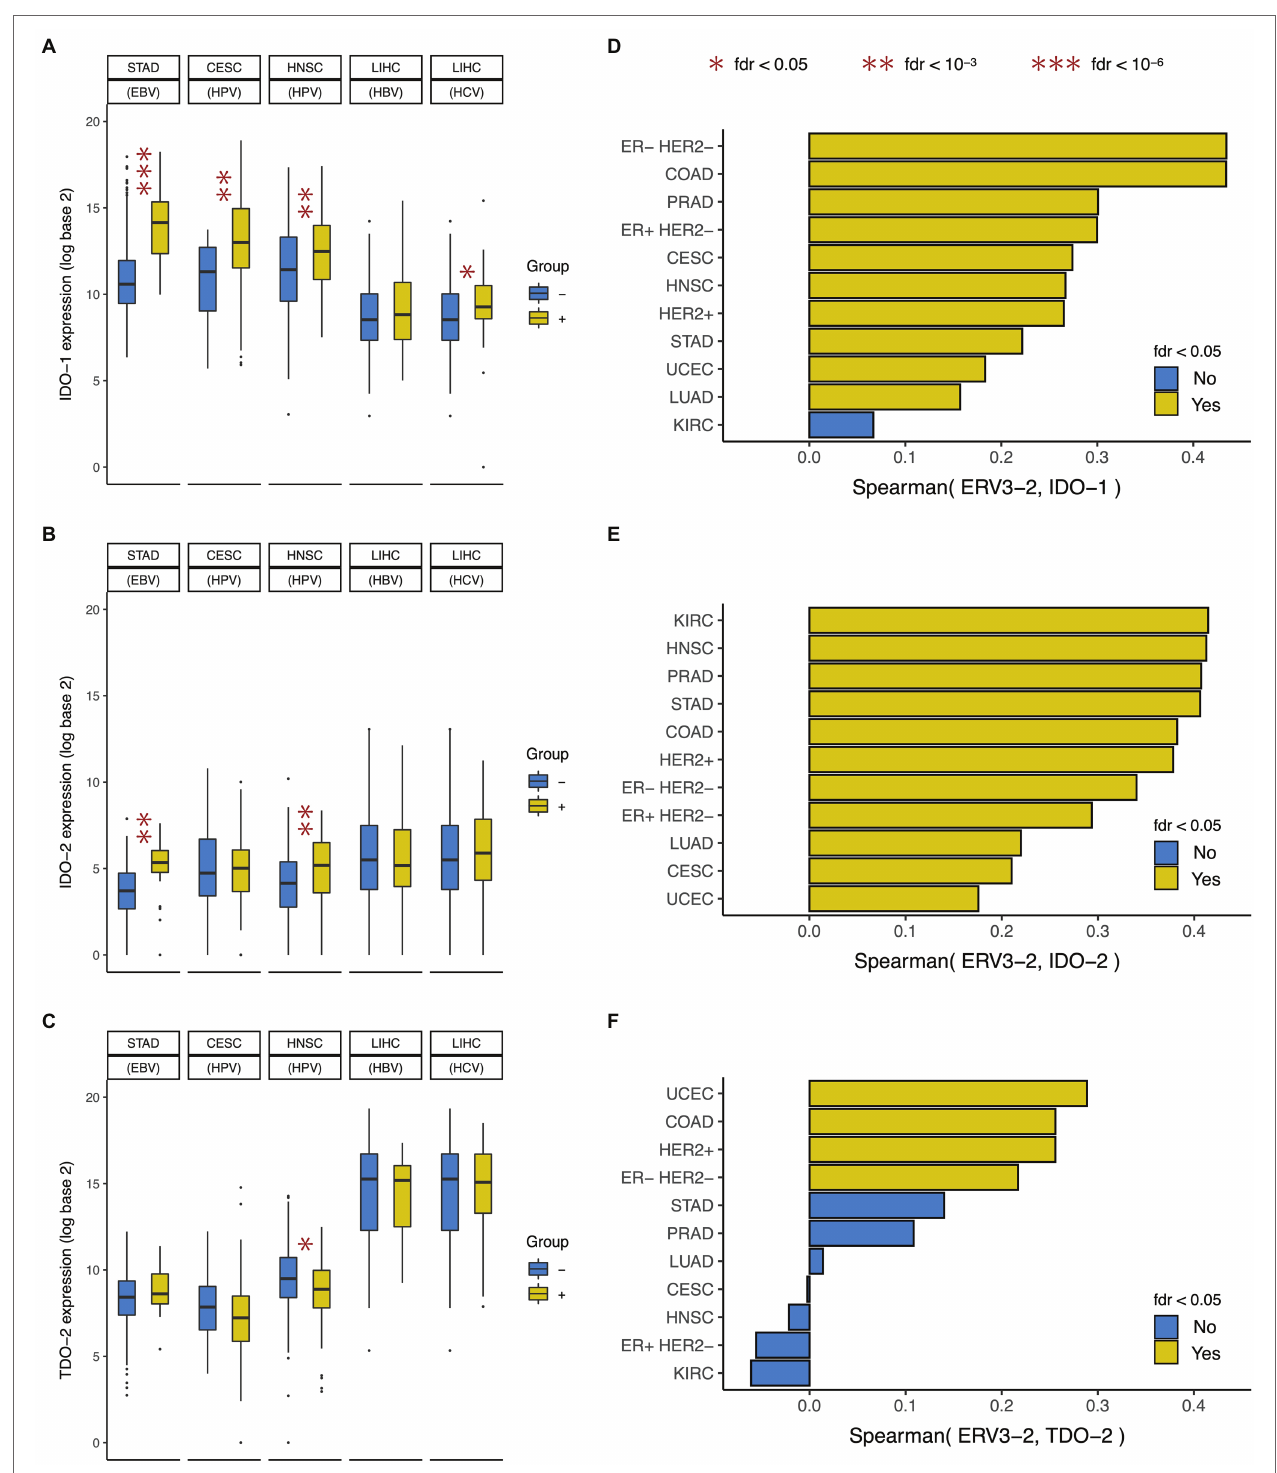
FIGURE 4 | Association between IDO pathway expression and viral expression in tumor. Expression of (A) IDO-1 , (B) IDO-2 , and (C) TDO-2 in tumors positive and negative for Epstein-Barr virus (EBV), Human papilloma virus (HPV), Hepatitis B virus (HBV), and Hepatitis C virus (HCV). Correlation between expressions of ERV3-2 and (D) IDO-1 , (E) IDO-2 , and (F) TDO-2 . Cancer type acronyms are standard TCGA abbreviations (https://gdc.cancer.gov/resources-tcga-users/tcga-code-tables/ tcga-study-abbreviations). In liver cancer, the negative group only includes tumors negative for both HBV and HCV (i.e., HBV − HCV − ) and does not include tumors that are HBV+ HCV − or HBV − HCV+. FDR, false discovery rate. * fdr < 0.05, ** fdr < 10 -3 , and *** fdr < 10 -6